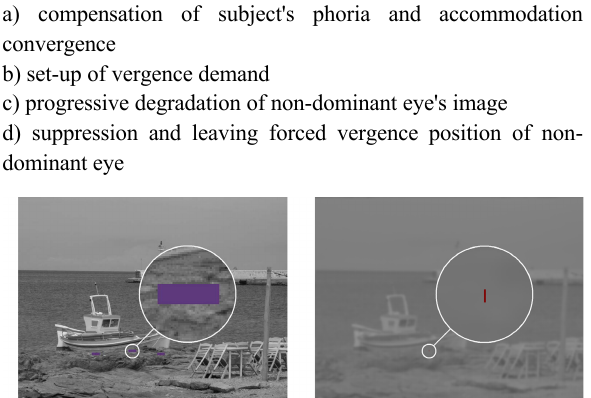
Figure 4. Experimental design of dichoptic suppressive threshold detection.